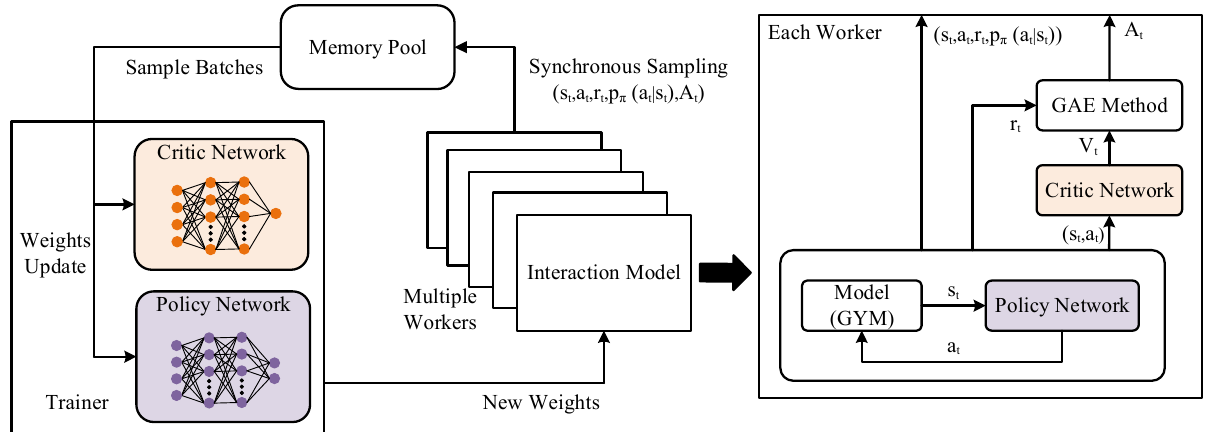
Figure 5. The training process of guidance controller by the distributed reinforcement learning (RL) Batch-PPO (proximal policy optimization) algorithm.